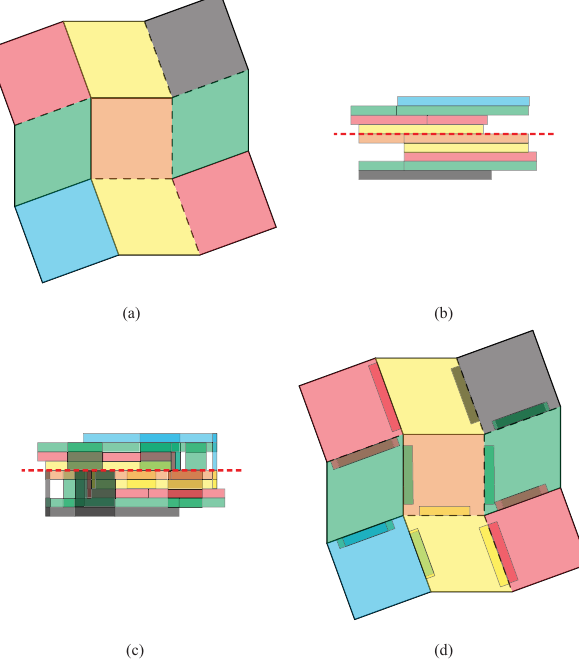
Figure 7. A schematic of (a) the pattern used in the design of the foldable circuit board. (b) A side view of the panel stack and the joint plane. (c) The stacked panels with offsets. (d) The unfolded pattern with the offsets. (b) and (c) are 2X scale.